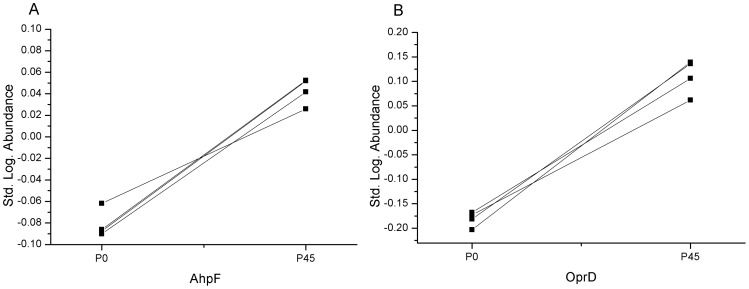
Logarithmic standard abundance of identified proteins of adapted and non-adapted P. aeruginosa PAO1.Logarithmic standard abundance is the decadal logarithm of the ratio of an individual protein spot and the internal standard within the same gel [54]. Individual values were in case of AhpF for P0 −0.087709; −0.086223; −0.06188; −0.090214 and P45 0.051973; 0.05241; 0.025915; 0.041694. For OprD, the logarithmic abundances were in case of P0 −0.167843; −0.172957; −0.202919; −0.181265 and for P45 0.105833; 0.0618; 0.139092; 0.136039. Exact ANOVA q-values (including FDR) for both protein spots were q = 0.008. Excluding FDR the p- value for AhpF was 1.33 10−6 and 5.7 10−6 for OprD respectively.